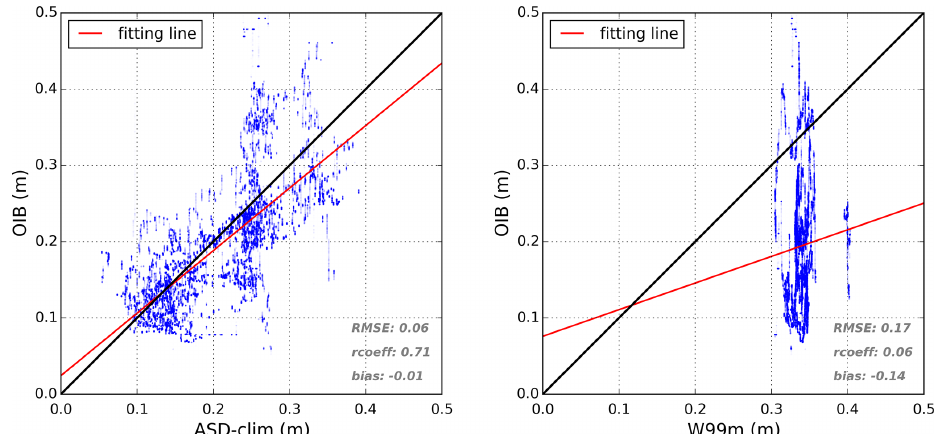
Figure 10. Scatterplots comparing the ASD and the W99m climatologies with OIB by considering all the tracks of the 2009, 2010, 2011 and 2012 OIB missions.